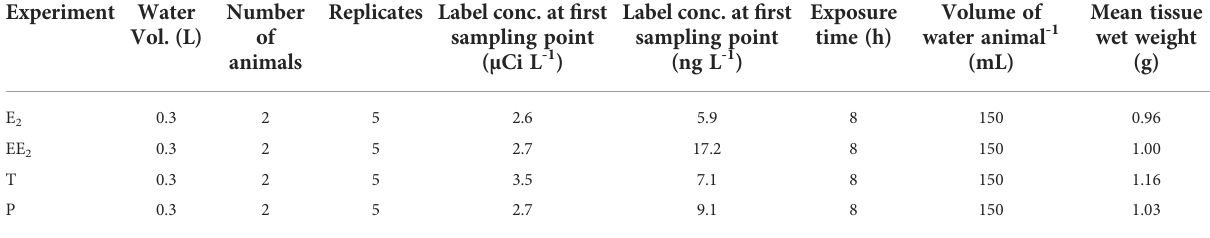
TABLE 1 Experimental conditions and basic animal